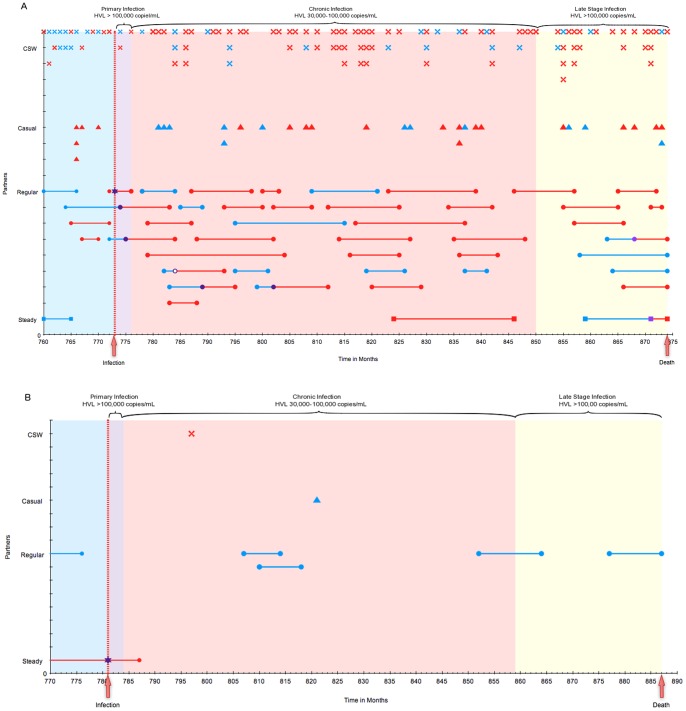
Trace plot of a selected high-risk and low-risk male.In this figure, each month is represented on the horizontal axis with multiple partners per month plotted vertically. Partnership types are represented as follows: ▪ for steady partnerships, • for regular partnerships, ▴ for casual partnerships, and X for CSW partnership. A blue symbol represents an HIV-uninfected female partner, a purple symbol a female partner that becomes HIV-infected that month and a red symbol a female partner who is previously HIV-infected. The duration of steady and regular partnerships are represented by a line; if that partner acquires HIV during the partnership, the time of HIV acquisition is represented by a purple symbol and a change in color of the line from green to red. The stage of HIV disease is depicted by the graph fill color, with green representing HIV-uninfected, purple primary infection, red chronic infection and yellow late-stage infection. This male depicted in Panel A is a typical high-risk male and in Panel B a typical low-risk male.